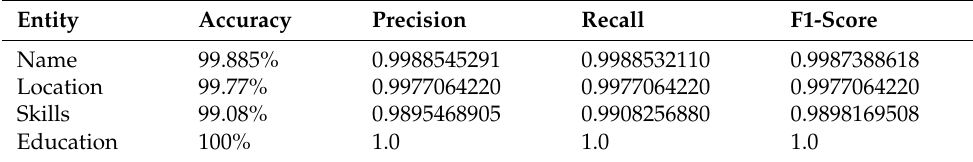
Table 2. Validating the prediction.